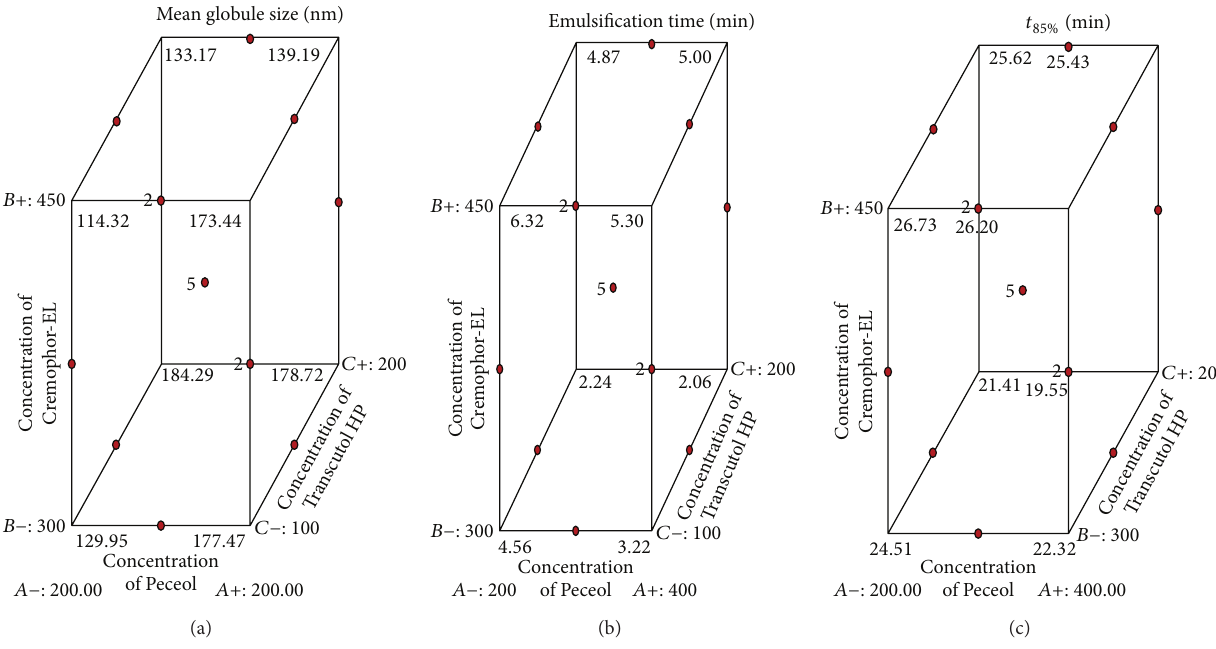
Figure 3: Cube surface graphs for the responses of Peceol, Cremophor-EL, and Transcutol HP.